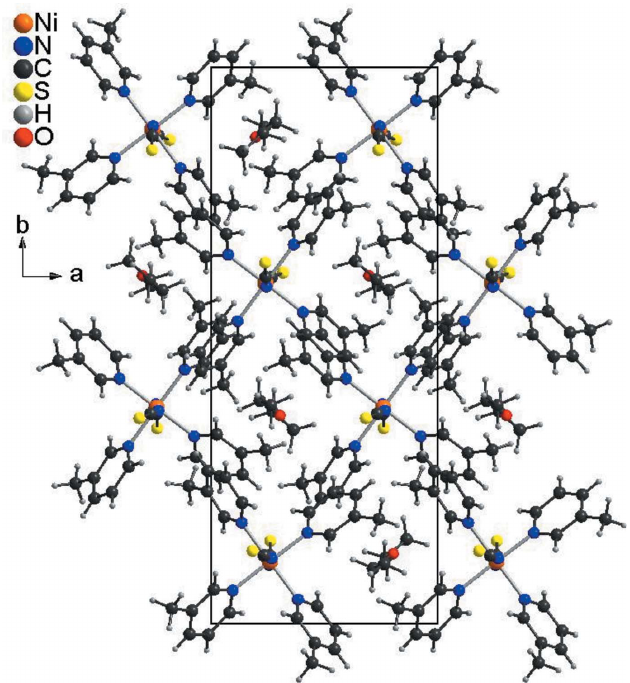
Figure 5 Crystal structure of compound 3 with view along the crystallographic c -